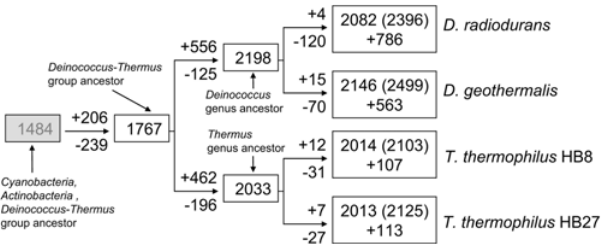
Figure 2. Whole genome evolutionary reconstructions for D.radio- durans,D.geothermalis,T.thermophilus(HB8) and T.thermophilus (HB27). For each internal node of tree (open boxes), the inferred number of tdCOGs is shown. For each tree branch the inferred number of tdCOGs lost (minus sign) and gained (plus sign) is shown. For the deep ancestor of the Cyanobacteria, Actinobacteria and Deinococcus- Thermus group (shaded box), the inferred number of COGs is shown. For the extant species, the number of tdCOGs, the number of proteins in tdCOGs (in parentheses), and the number of ‘‘free’’ (not assigned to tdCOGs) proteins (plus sign) are shown.